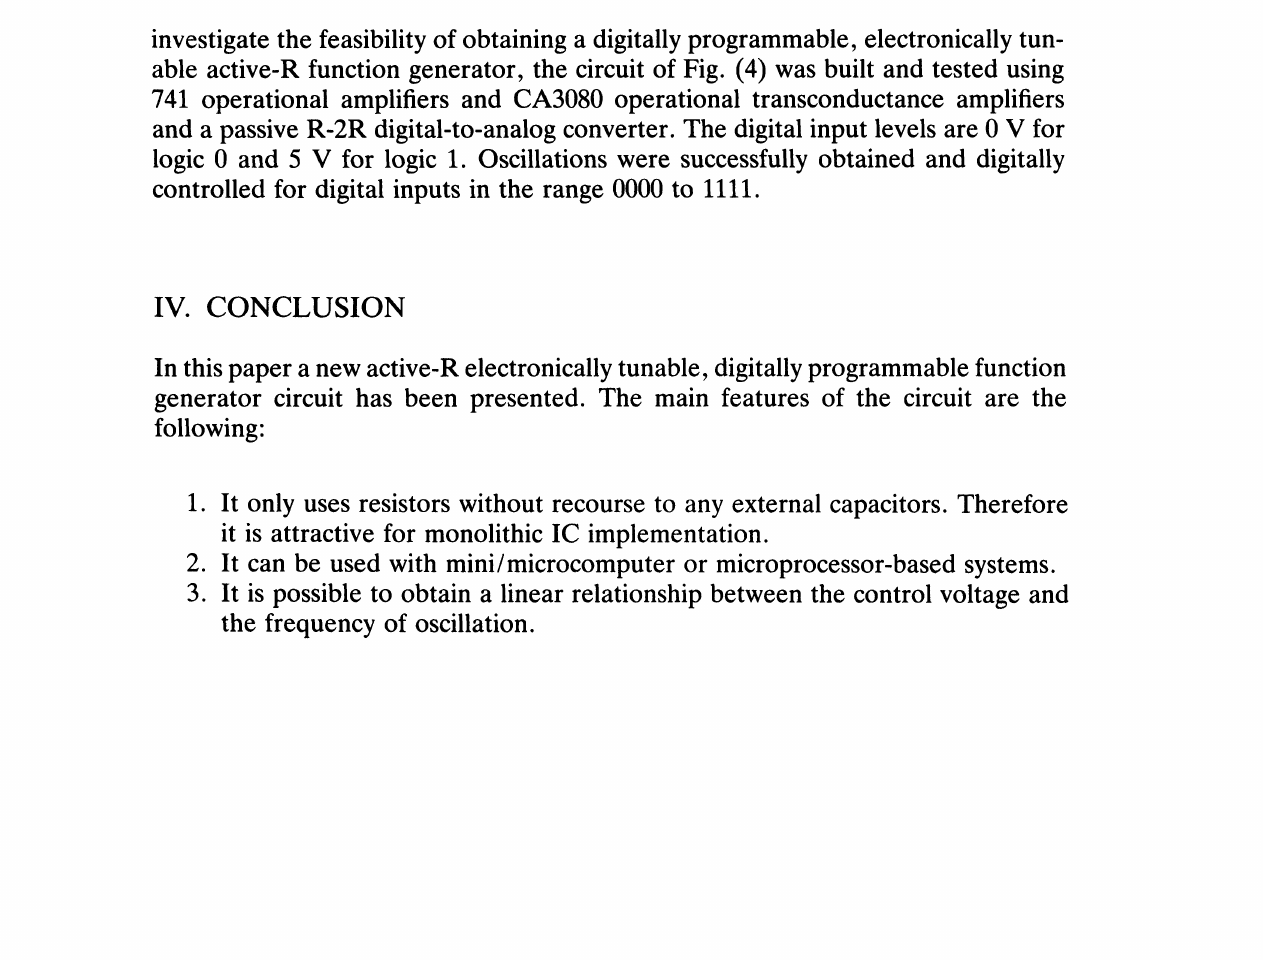
FIGURE 3 Proposed electronically tunable